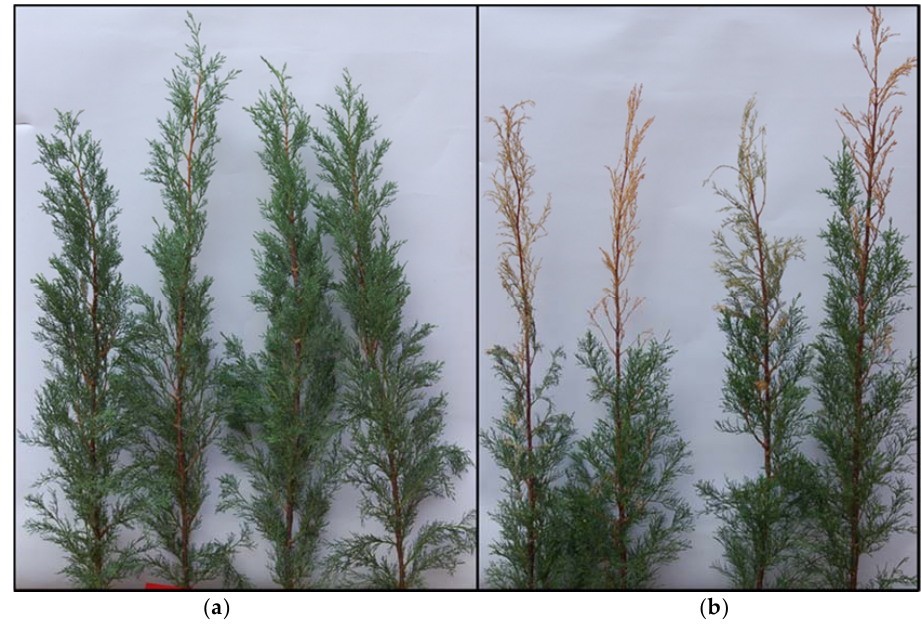
Figure 1. Cupressus sempervirens L. clones 3 months after multiple artificial stem inoculation with the cypress canker disease fungal agent S. cardinale . ( a ) Resistant (R); ( b ) Susceptible (S). The susceptible ramets displayed the dieback of crown portions due to the effect of the bark pathogen that completely girdled the inoculated axes.